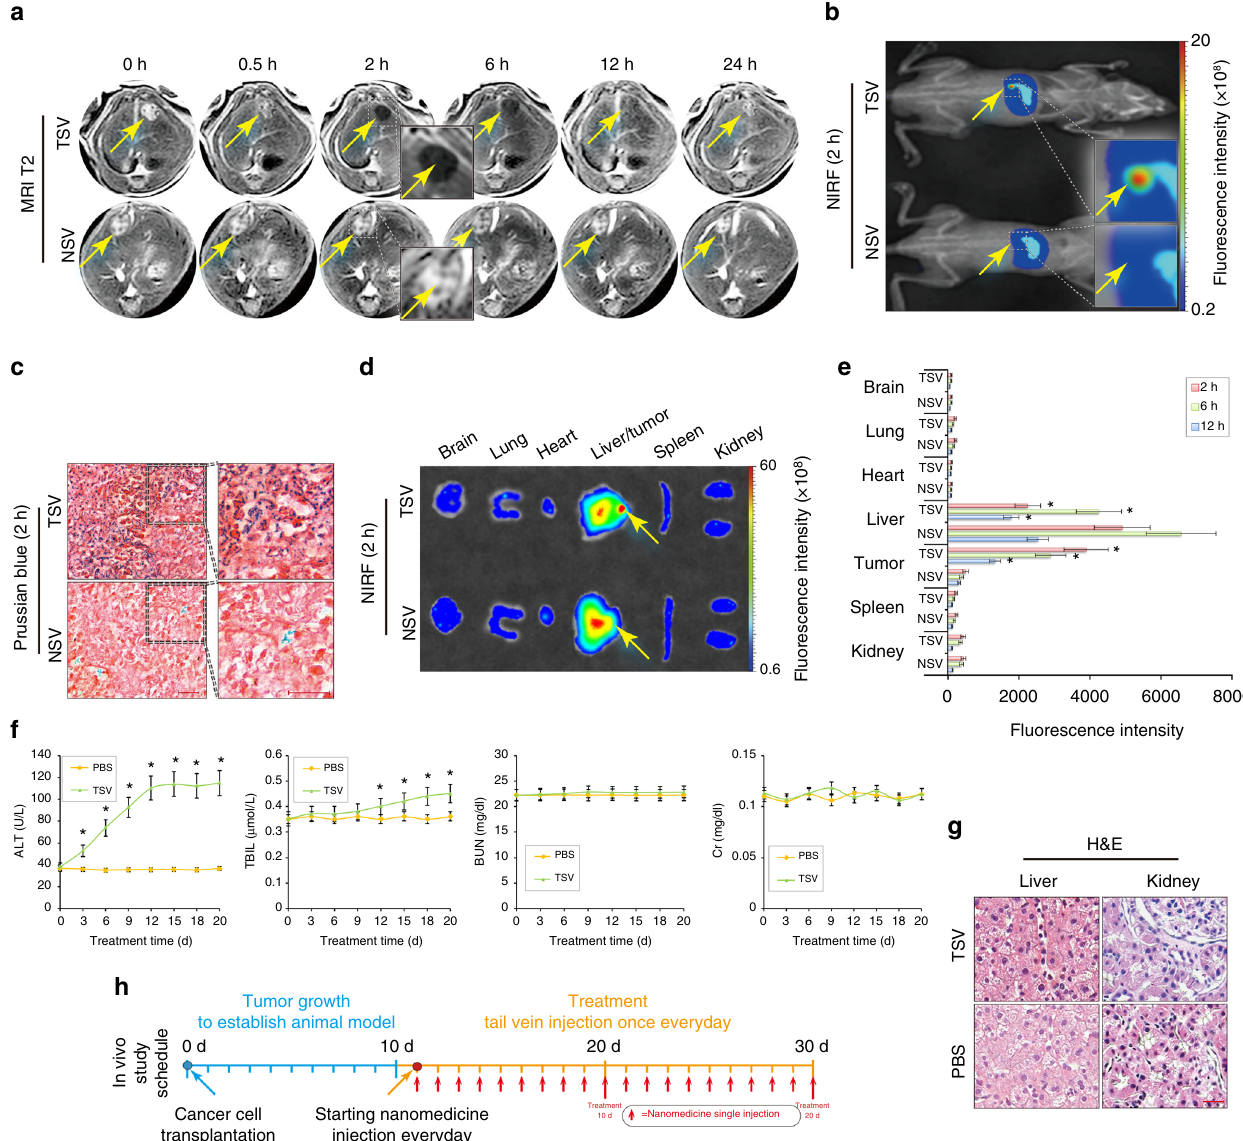
Fig. 4 In vivo biodistribution and toxicological study of theranostical nanomedicine in Hep3B liver orthotropic model. a T2-weighted MRI examination showing a nonlinear change in tumor signal intensity against tracing time (0, 0.5, 2, 6, 12, and 24 h after tail vein single injection). Yellow arrows indicate the location of the tumor. b Near-infrared fl uorescence (NIRF) imaging of mice 2 h after nanomedicine single injection. The fl uorescent reporter used for NIRF was Alexa Fluor 750. Yellow arrows indicate the location of the tumor (See also Supplementary Fig. 10). c Prussian blue staining performed on histological sections of orthotropic tumors 2 h after single injection. Scale bar, 100 μ m. d NIRF images of various mice organs harvested 2 h after nanomedicine single injection (see also Supplementary Fig. 10). e Averaged fl uorescence intensities of mice tumors and major organs at 2, 6, and 12 h after a single injection of nanomedicine. f Serum liver function markers alanine transaminase (ALT)/total bilirubin (TBIL) and renal function markers blood urea nitrogen (BUN)/creatinine (Cr) were assessed during the period from 0 to 20 days after namomedicine injection once a day under therapeutic dosage (plasmid dose 8 μ g). g Haematoxylin and eosin (H&E) staining of the liver and kidney tissues from mice after 20 days of treatment for evaluations of tissue in fl ammation and structural damage. Scale bar, 20 μ m. (nanomedicine injected once a day at plasmid dose 8 μ g). h Schedule illustration of in vivo study. Data were represented as means± S.D. Error bars represent the S.D. values ( n = 12, * P < 0.05, Student ’ s t test, compared with NSV group or PBS control